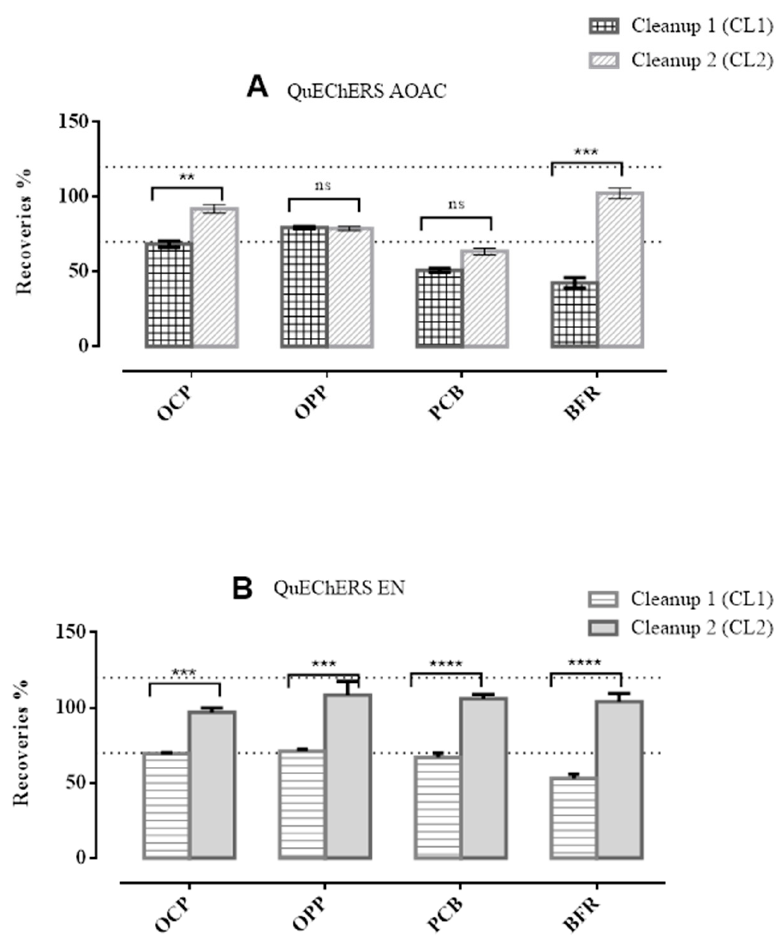
Figure 3. Mean extraction recoveries (%) of the targeted multiple contaminants divided into four chemicals groups (OCP, p -value = 0.006; OPP, p -value = 1; PCB, p -value = 0.06 and BFR, p -value = 0.0002) using QuEChERS AOAC ( A ) and QuEChERS EN ( B ). Two-way ANOVA analysis with Sidak’s multiple comparisons test (ns: Non-significant; **/***/****—significant).